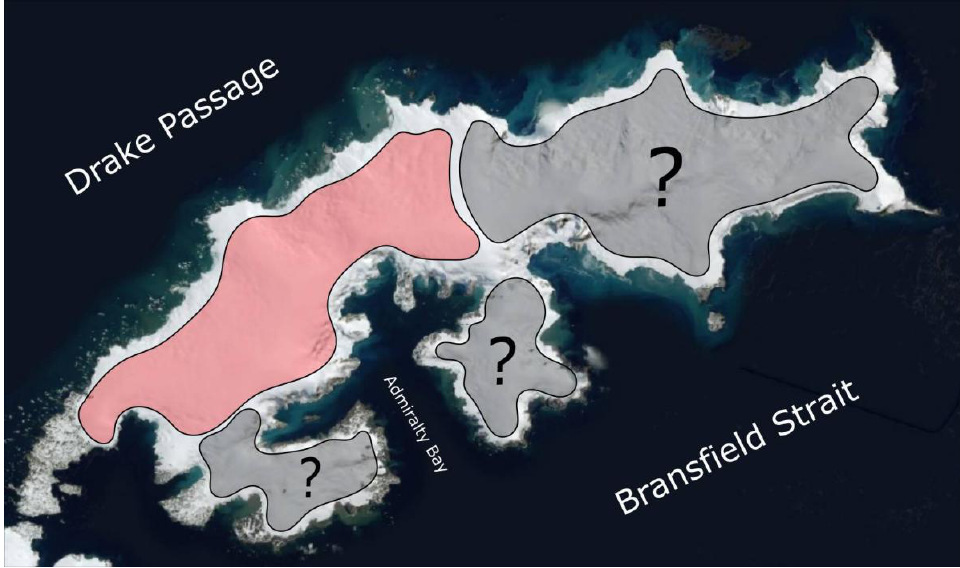
Figure 18. Schematic map of areas covered by historical GPR measurements. The red area was covered by past measurements; the grey area was not covered by past measurements.